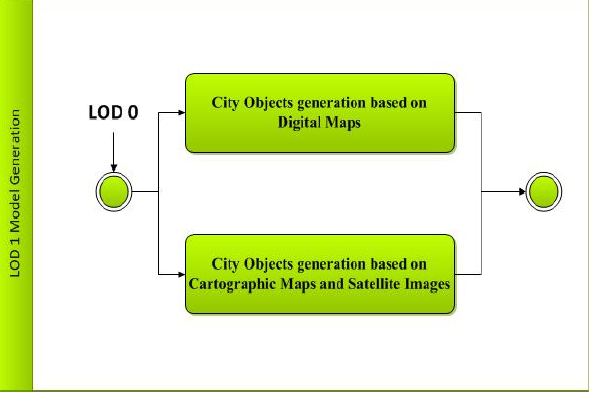
Figure 3 . LOD 1 Model generation processes